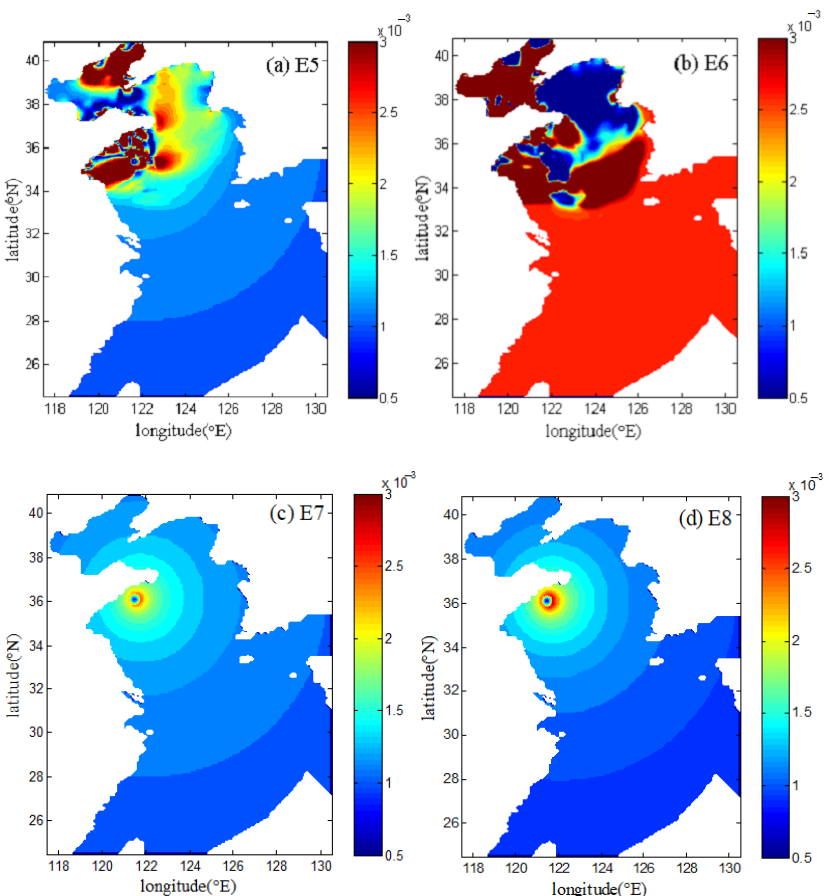
Figure 7. Spatial distributions of the calculated drag coefficients in E5 − E8 ( a – d ) at 14:00 p.m. on 19 July 1973 during Typhoon 7303.